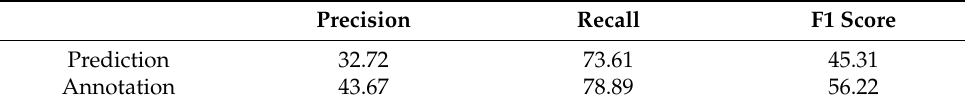
Table 3. Precision (%) , Recall (%) , and F1 score (%) of the SSMA-PB system on predicting phrase boundaries from texts and annotating phrase boundaries by forced-alignment. Precision Recall F1 Score